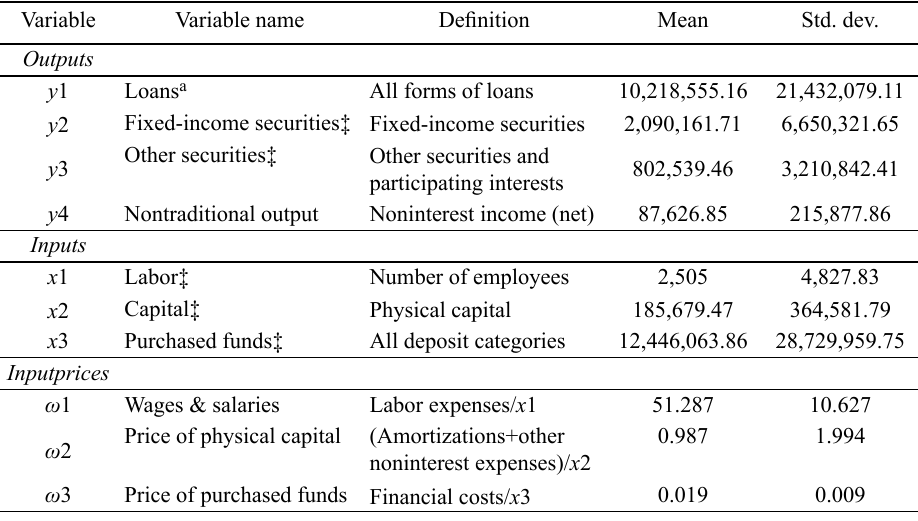
Table 1. Definition of the relevant variables,